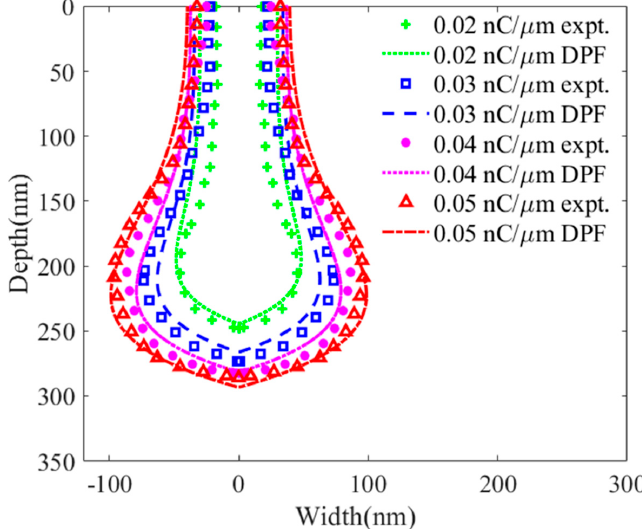
Figure 8. Experiments and DPF calculations of the amorphous damage profile of silicon substrate treated with He-FIB at a beam energy of 25 keV with ion doses of 0.02, 0.03, 0.04 and 0.05 nC/ μ m.